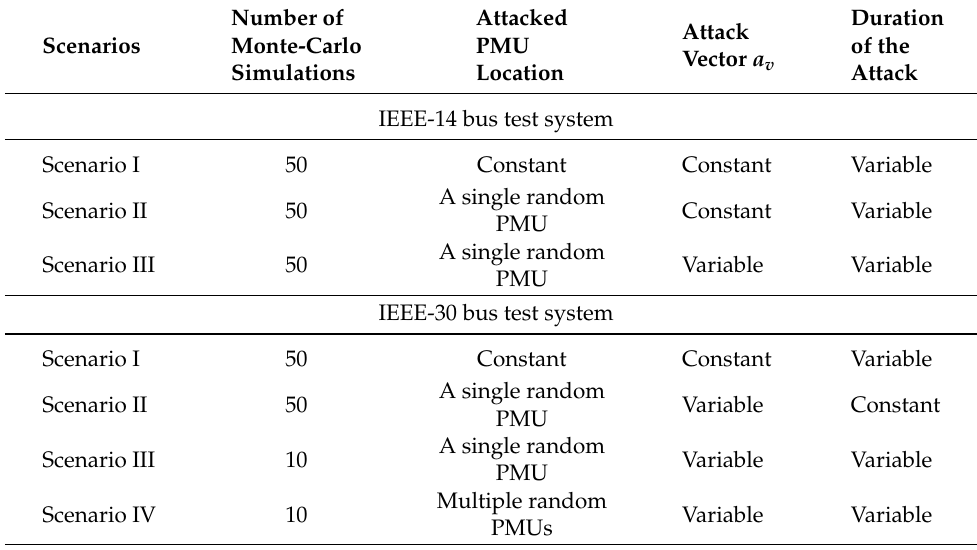
Table 3. Summary of Scenarios of the FDIs